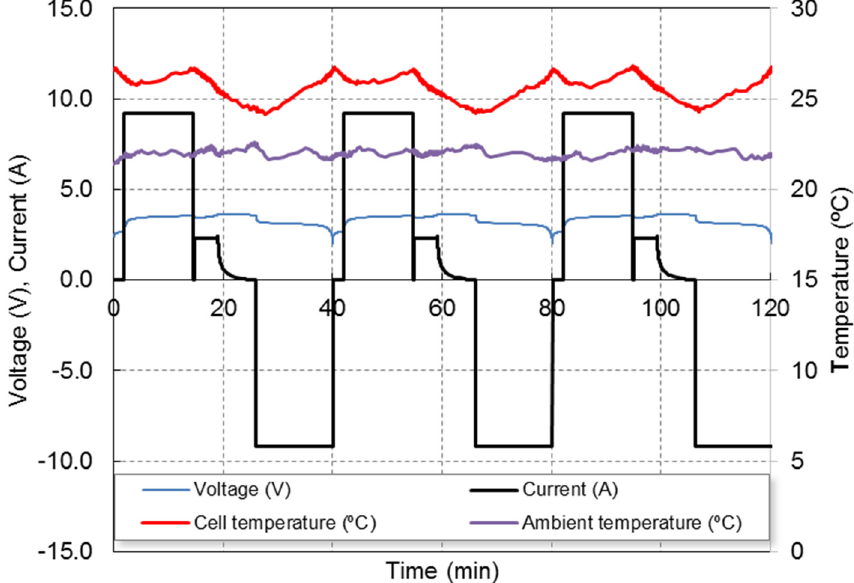
Figure 1. Cell temperature, current and voltage evolution during 4C-1C-constant voltage (CV)/4C